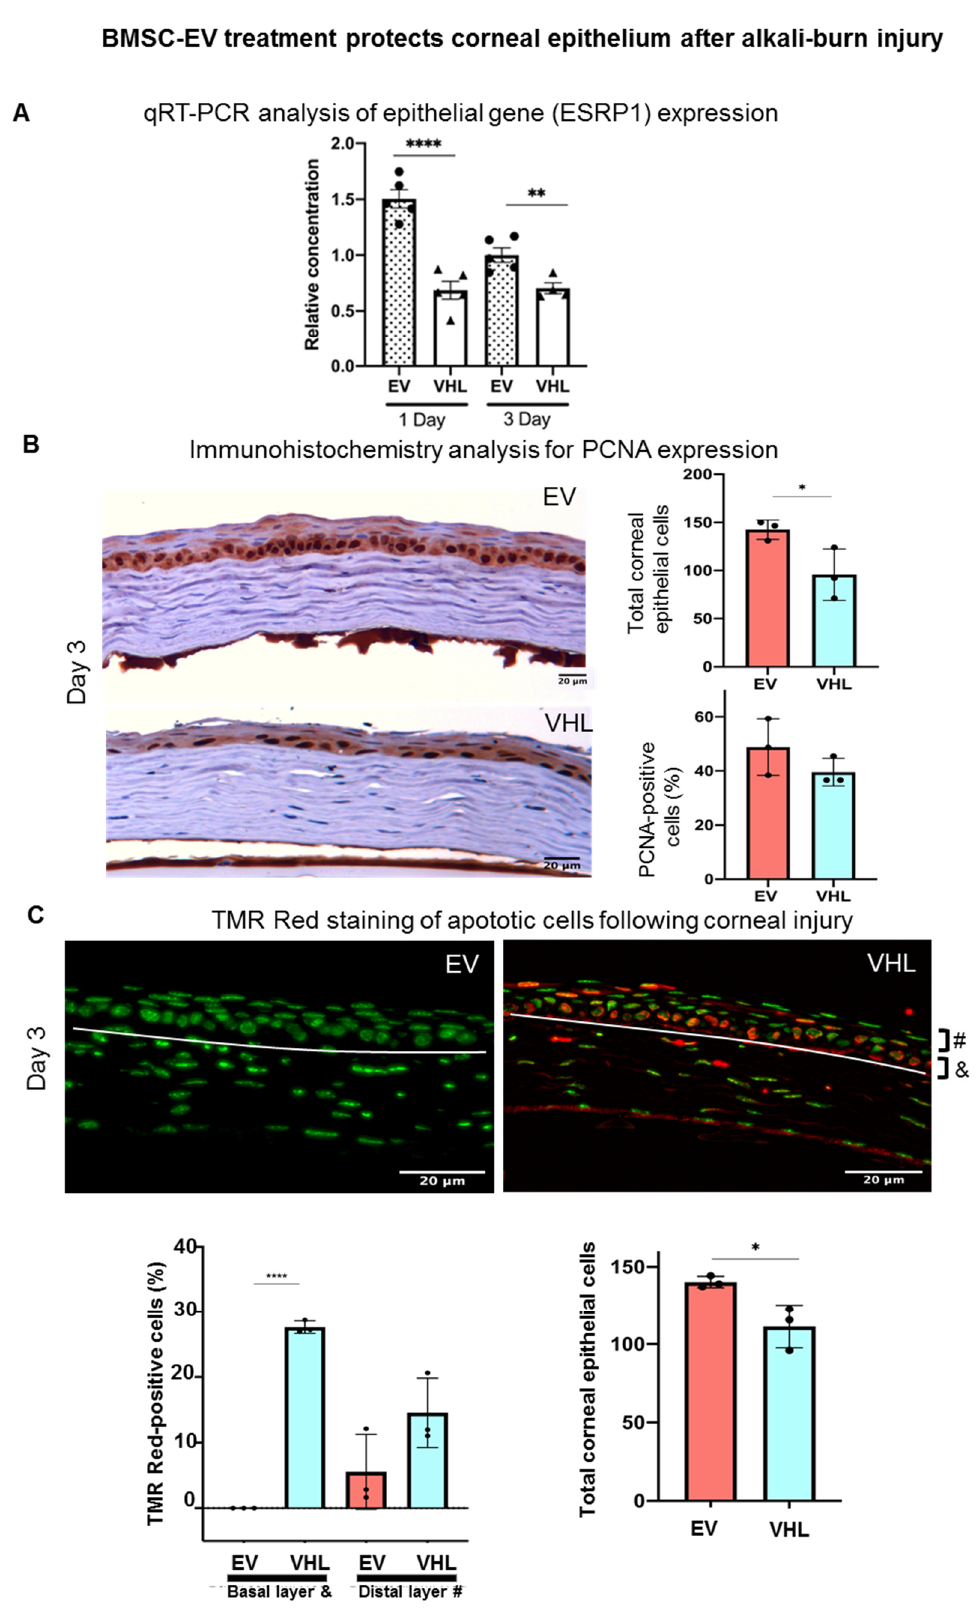
Figure 5. BMSC-EV treatment protects the corneal epithelium after alkali-burn injury. ( A ) The expression of Esrp1, a marker of epitheliality, is shown at day 1 and day 3 post-EV or VHL treatment in the injured corneas; n = 5, ** p < 0.01, **** p < 0.0001. ● represents biological replicates with EVs